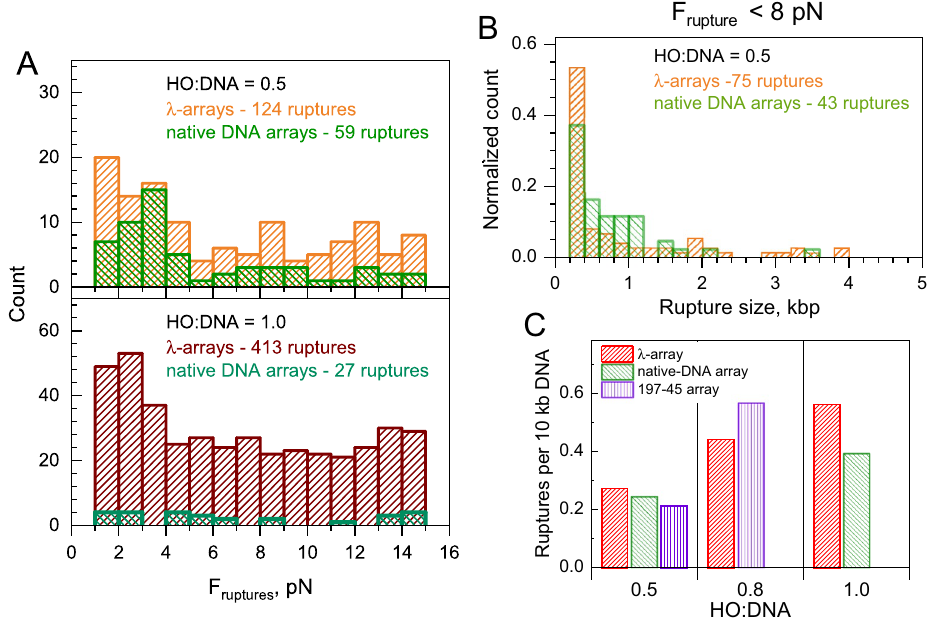
Figure 5. Analysis of the cluster–cluster ruptures in the λ-arrays, native DNA arrays, and 197-45 arrays. ( A ). Distribution of rupture force ( F rupture ) observed for the λ-arrays with HO:DNA ratios 0.5 (top, orange bars) and 1.0 (bottom, dark red bars) in comparison with the data obtained for the native arrays with similar HO:DNA ratios (green bars). The total number of ruptures recorded for each array type is indicated in the graphs. ( B ). Normalized distribution of the cluster–cluster distance determined for the λ-arrays for F rupture < 8 pN. HO:DNA ratios and numbers of the observed ruptures are indicated on the graphs. The distance is expressed in kbp DNA. The data obtained for the λ-arrays at HO:DNA = 0.8 and for the 45-197 arrays HO:DNA = 0.5, 0.8, and 1.0 are presented in Fig. S9 of the Supplementary Data. ( C ). The number of the cluster–cluster ruptures normalized to 10 kb DNA using F rupture < 8 pN cutoff and the number of the recorded traces at different HO:DNA ratios. The number of ruptures obtained for the 197-45 array at HO:DNA = 1.0 is not shown due to the small number of data (9 traces and 11 cluster–cluster ruptures). OriginPro software 75 (http:// www. origi nlab. com) was used to create the